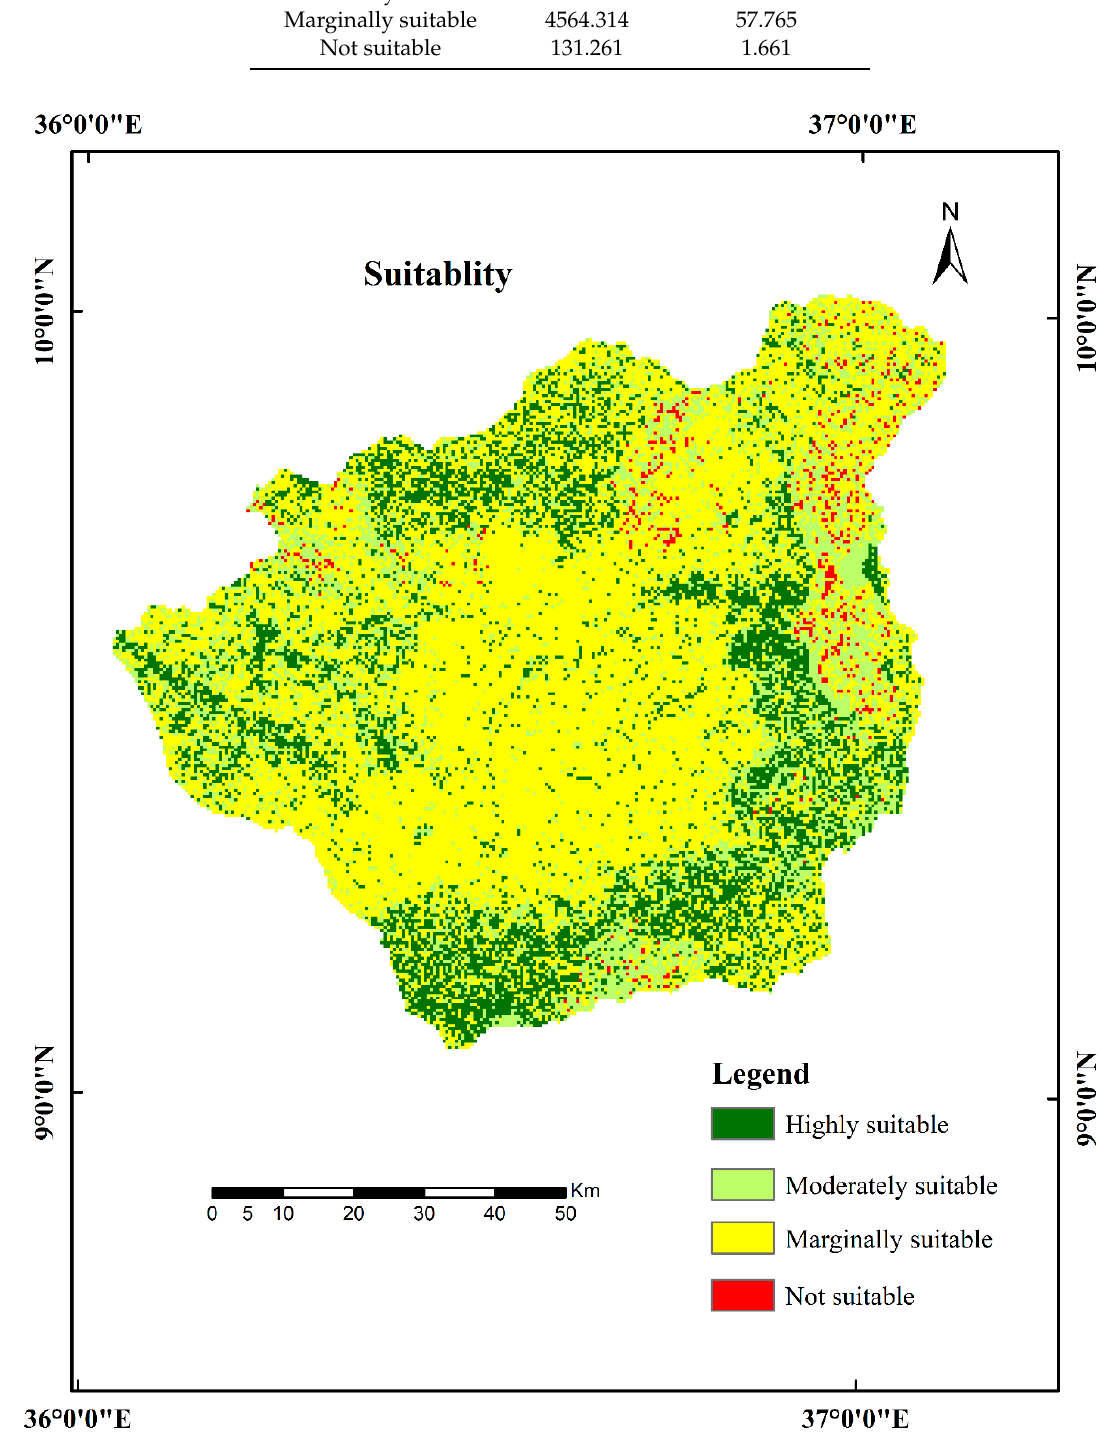
Figure 7. Agricultural land suitability of Anger Sub-basin.